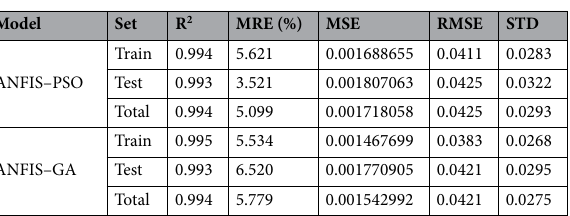
Table 2. The statistical parameters of proposed ANFIS-GA and ANFIS-PSO